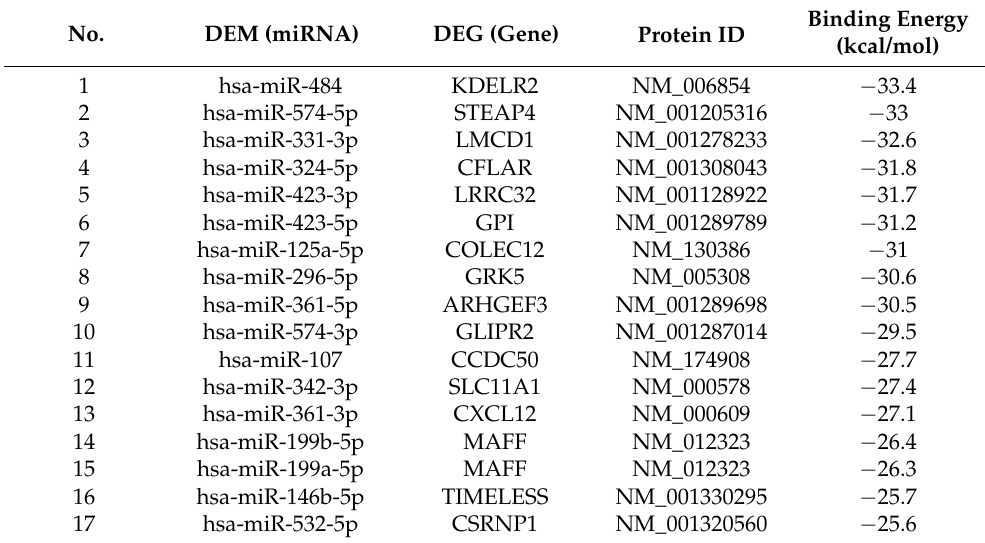
Table 2. DEG–DEM interaction prediction. This table only shows one interaction of one DEM, i.e., part of the results. The full table is shown in the Supplementary Materials (Table S2).